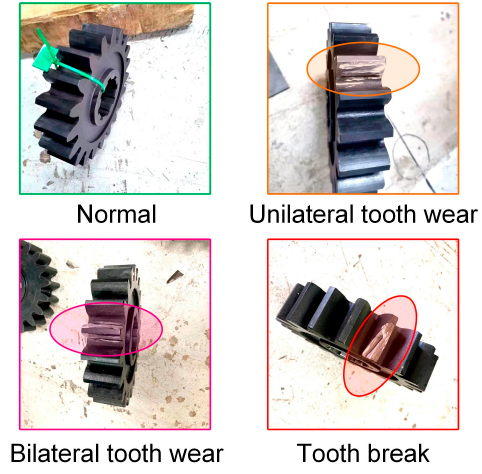
Figure 20. Fault injection of the driving gear.